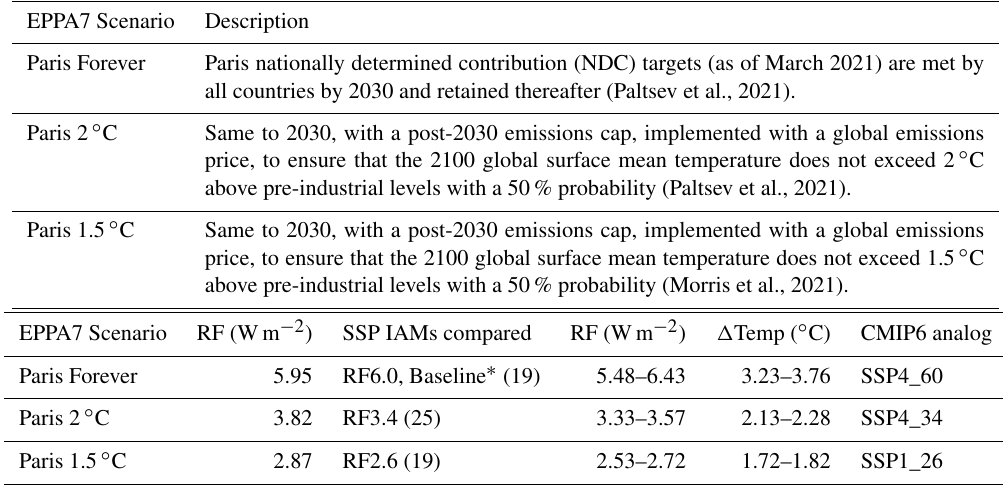
Table 2. EPPA7 scenarios analyzed, with selected SSP comparisons.